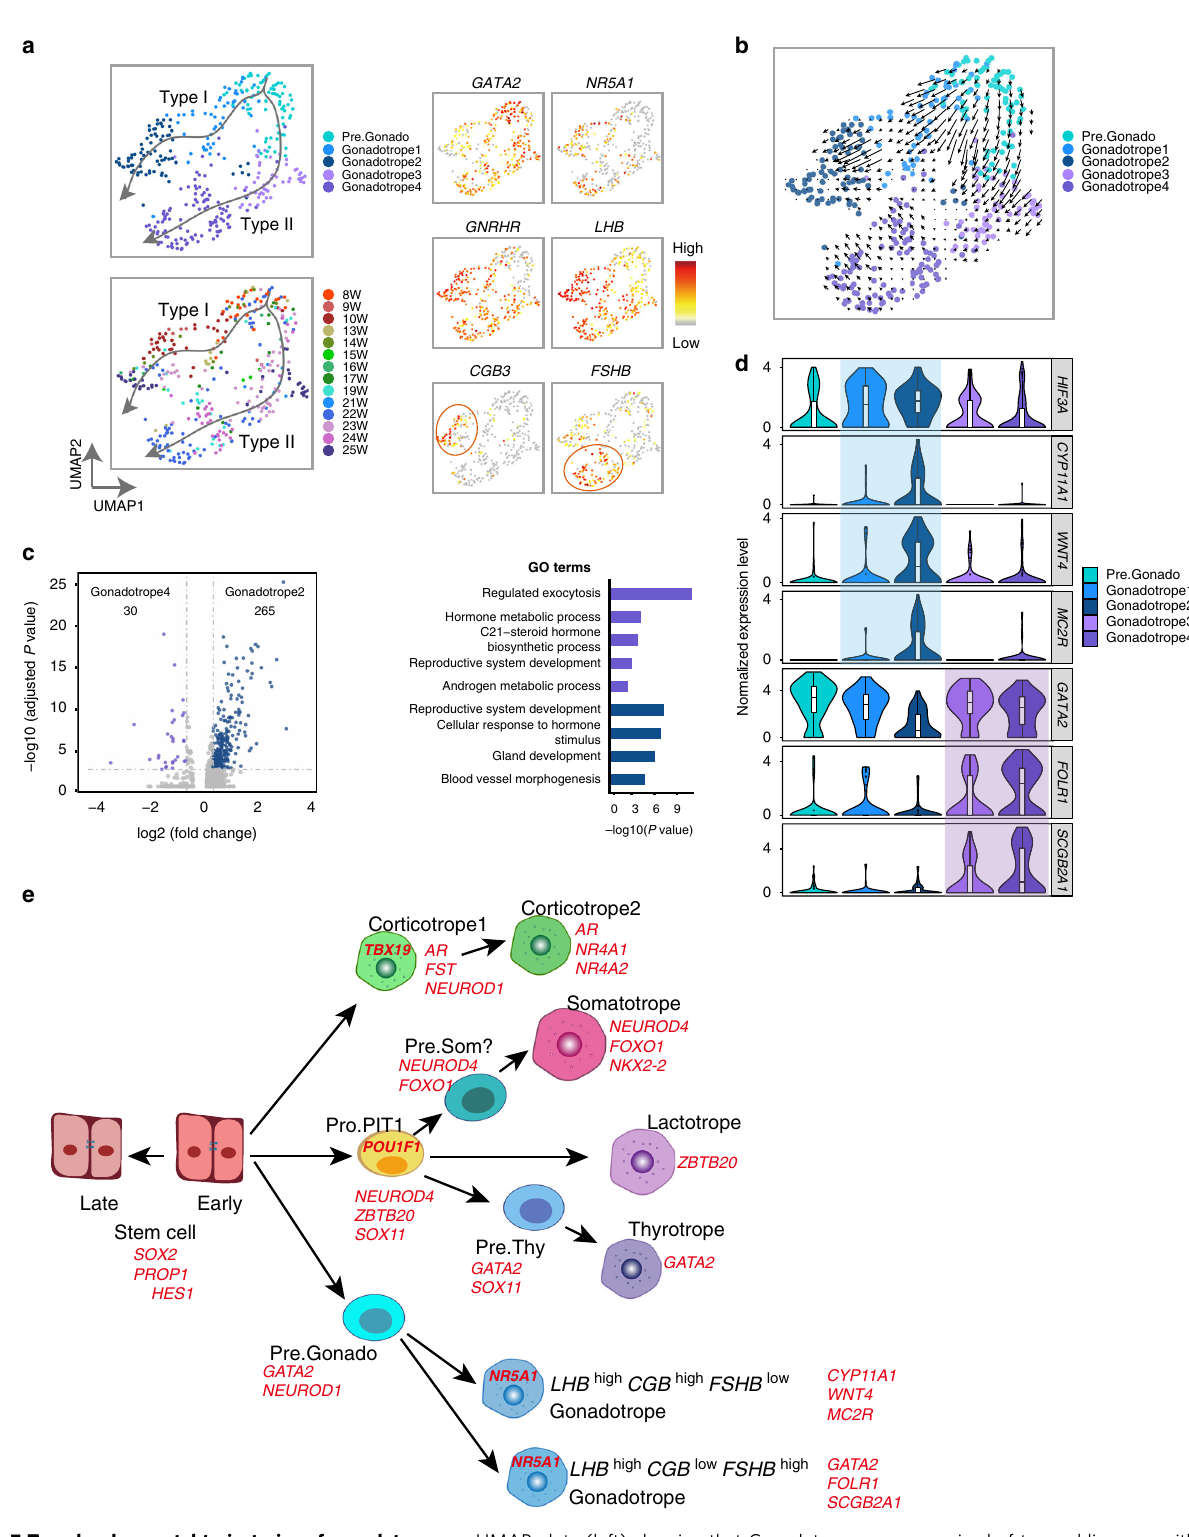
Fig. 7 Two developmental trajectories of gonadotropes. a UMAP plots (left) showing that Gonadotropes are comprised of two sublineages with scatterplots (right) showing the expression patterns of representative marker genes. Dots: single cells; colors: cell types (upper) or weeks postfertilization (lower). Gray to red indicate no to high expression levels. b RNA velocity analysis of gonadotropes projected onto the UMAP plot showing two sublineages. Dots: single cells; colors: cell types; arrows: predicted directions of the pseudotime. c Volcano plots (left) of DEGs between Gonadotrope2 and Gonadotrope4, with bar plots (right) showing GO terms enriched in each subtype. Colored dots indicate signi fi cant DEGs in each subtype. P -values are determined by two-sided Wilcoxon test and adjusted by Bonferroni correction. d Violin with inside box plots showing representative DEGs of two sublineages. e Diagram of the development of human fetal anterior pituitary. For a given stage, representative enriched TFs are highlighted. The Pre.Som is labeled with a question mark as this intermediated substate is supported by suf fi cient number of